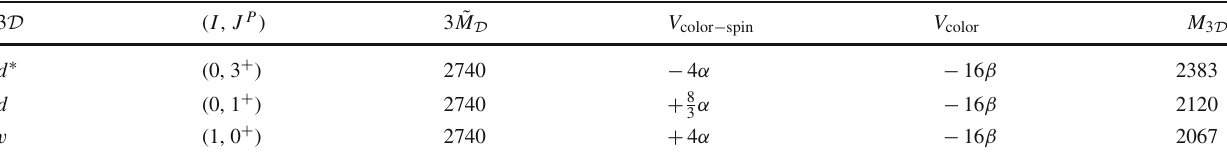
Table 1 DD color-spin and color interaction contributions to the listed total mass values M 3 D of selected 3 D dibaryons, using Eq. (A.3) with ˜ M D from Eq. (A.2). The qq interaction parameters from Ref. [7] are α = − 39 . 5 MeV, β = 32 . 15 MeV. Masses are given in